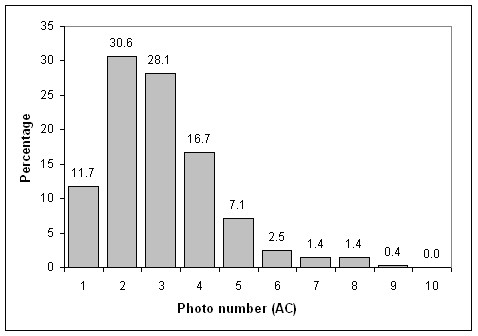
Distribution of AC grades in the sample of evaluated students.